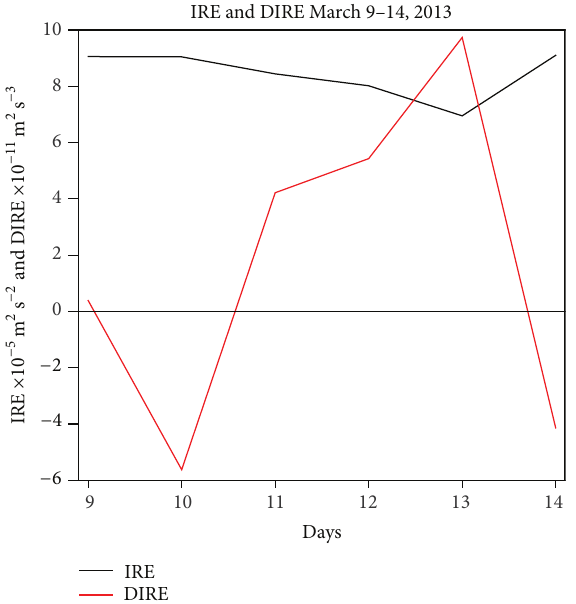
Figure 10: IRE and DIRE from ERA-Interim reanalysis for March 9–14, 2013. Figure 11: ERA and GEFS values of IRE for March 9–14, 2013.